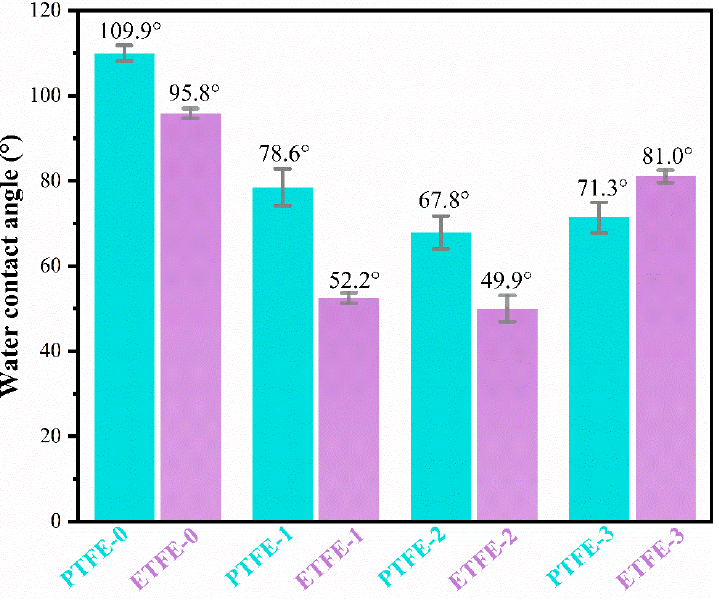
Figure 10. Comparison of the water contact angle of membrane before and after surface treatment. The water contact angle of the ETFE-1 and PTFE-1 membranes treated with helium ETFE-1 membrane decreased from 95.83 ◦ to 52.28 ◦ , a decrease of 45.45% relative to the ETFE-0 membrane. The PTFE-1 membrane decreased from 109.9 ◦ to 78.7 ◦ before